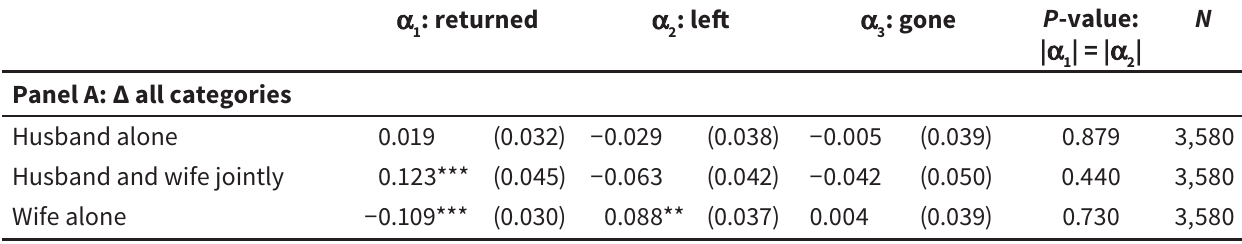
Dynamic shifts in decision-making power between husband and wife: first-difference approach